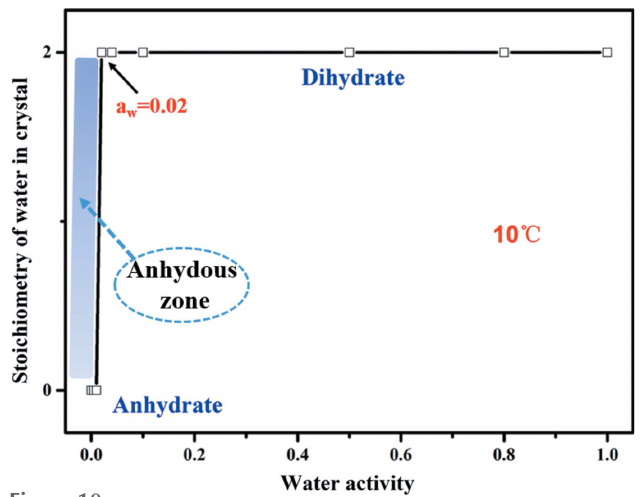
Figure 10 Phase diagram of the water activity of the PDA-OXA dihydrate and anhydrate at 10 (cid:3) C, which determined the boundary of transformation between the dihydrate and anhydrate